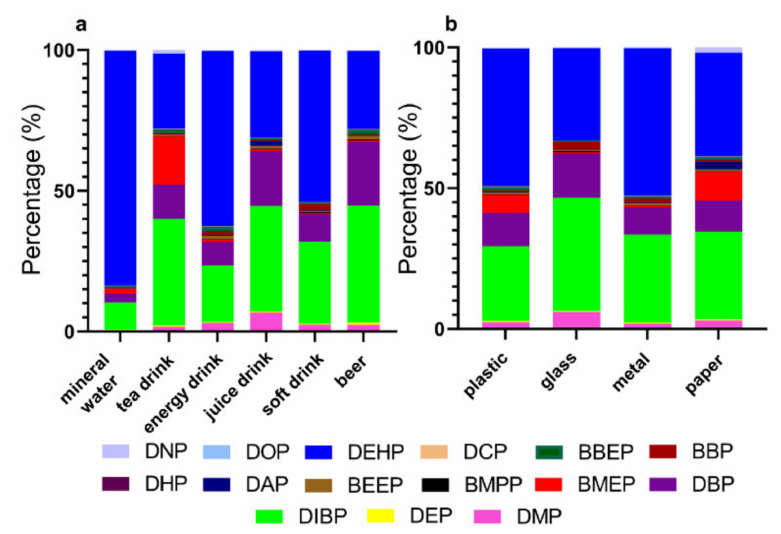
Figure 1. Compositions of total phthalates in different categories of bottled drinks: ( a ) Sorted by